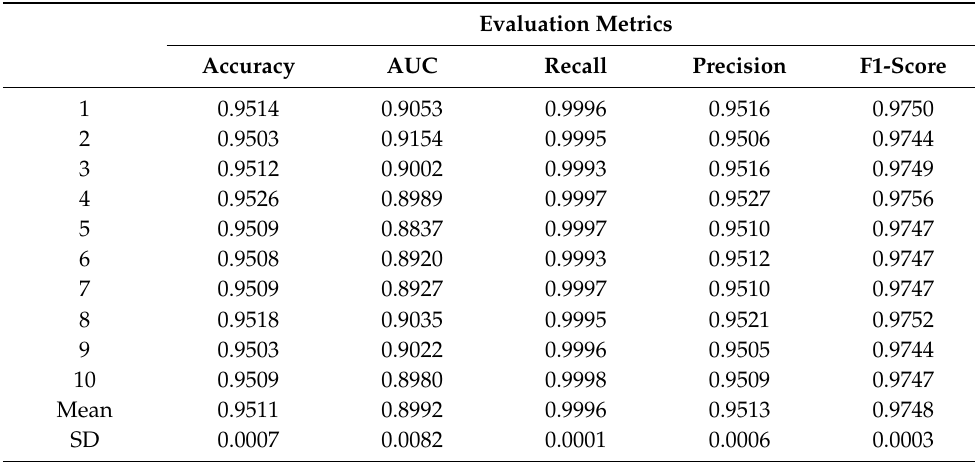
Table 8. The 10-fold cross-validation results for